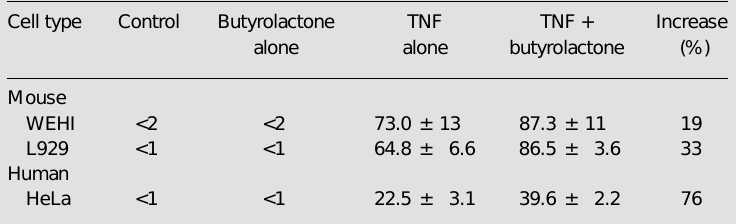
Table 1 - Induction of apoptotic cell death by tumor necrosis factor (TNF) and the combination of TNF plus butyrolactone in mouse and human cell lines. Cell lines were incubated without or with butyrolactone (100 µM) for 1 h and then with TNF. The concentration of TNF (mouse or human recombinant protein) added and time of incubation were, respectively, 1 ng/ml and 15 h for WEHI, 10 ng/ml and 24 h for L929, and 100 ng/ml and 24 h for HeLa. Apoptotic nuclei were scored on the basis of the condensation state of chromatin and its marginalization at the edges of the nuclear membrane. Data are reported as the mean percent of apoptotic cells ± standard deviation of the results of three similar